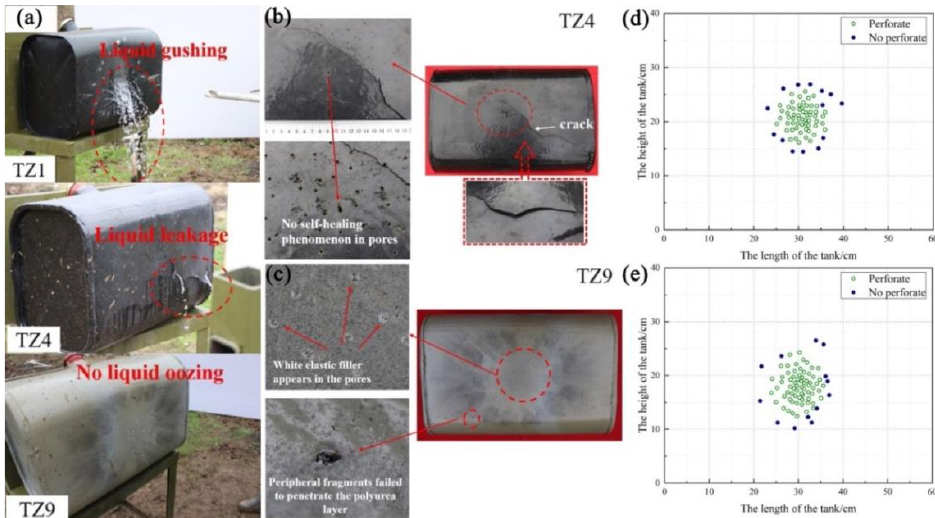
Figure 13. The damage of the tank after the combined action of shock waves and fragments: ( a ) Water seepage situation of the tank; Blast surface damage of ( b ) TZ4 and ( c ) TZ9; Fragment distribution of ( d ) TZ4 and ( e ) TZ9. The TZ1, TZ4 and TZ9 are the tanks without polyurea protection; 6 mm AMMT-53 polyurea-protected tank and 6 mm AMMT-55 polyurea-protected tank, respectively. Reproduced with permission from ref. [15].